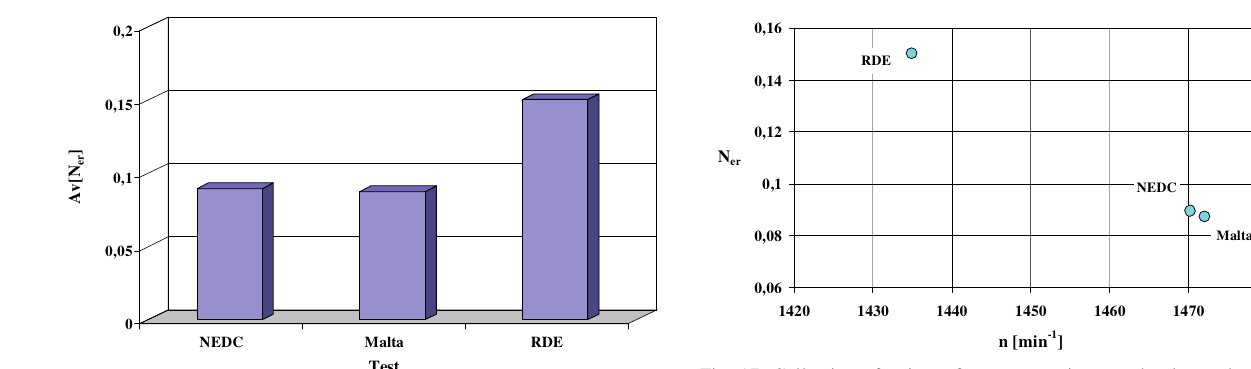
Fig. 17. Collection of points of average engine speed value and average value of relative engine power in coordinates of rotational speed–relative Fig. 14. The average value of the relative engine power in the NEDC, power in NEDC, Malta and RDE tests Malta and RDE tests